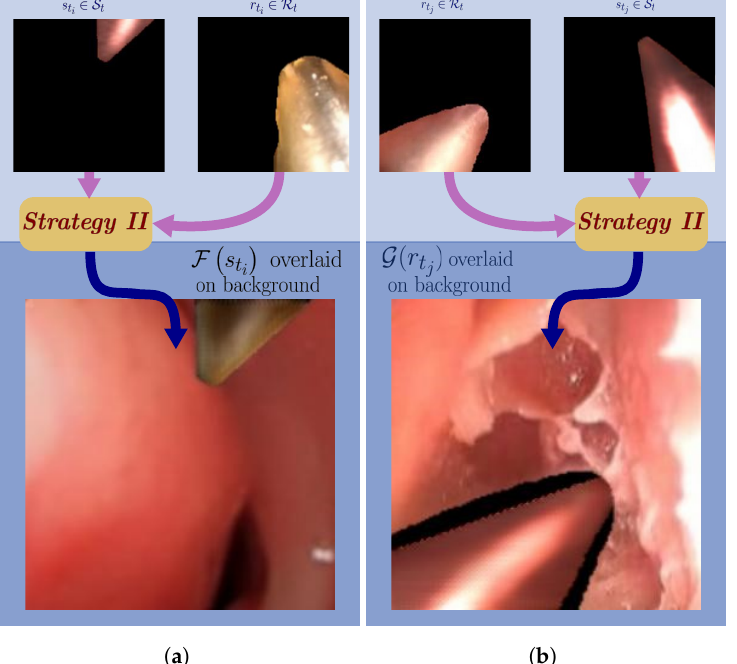
Figure 3. CycleGAN generated synthetic images from Strategy II : ( a ) The tool image was generated ignorant of the background; ( b ) the tool image borders are not